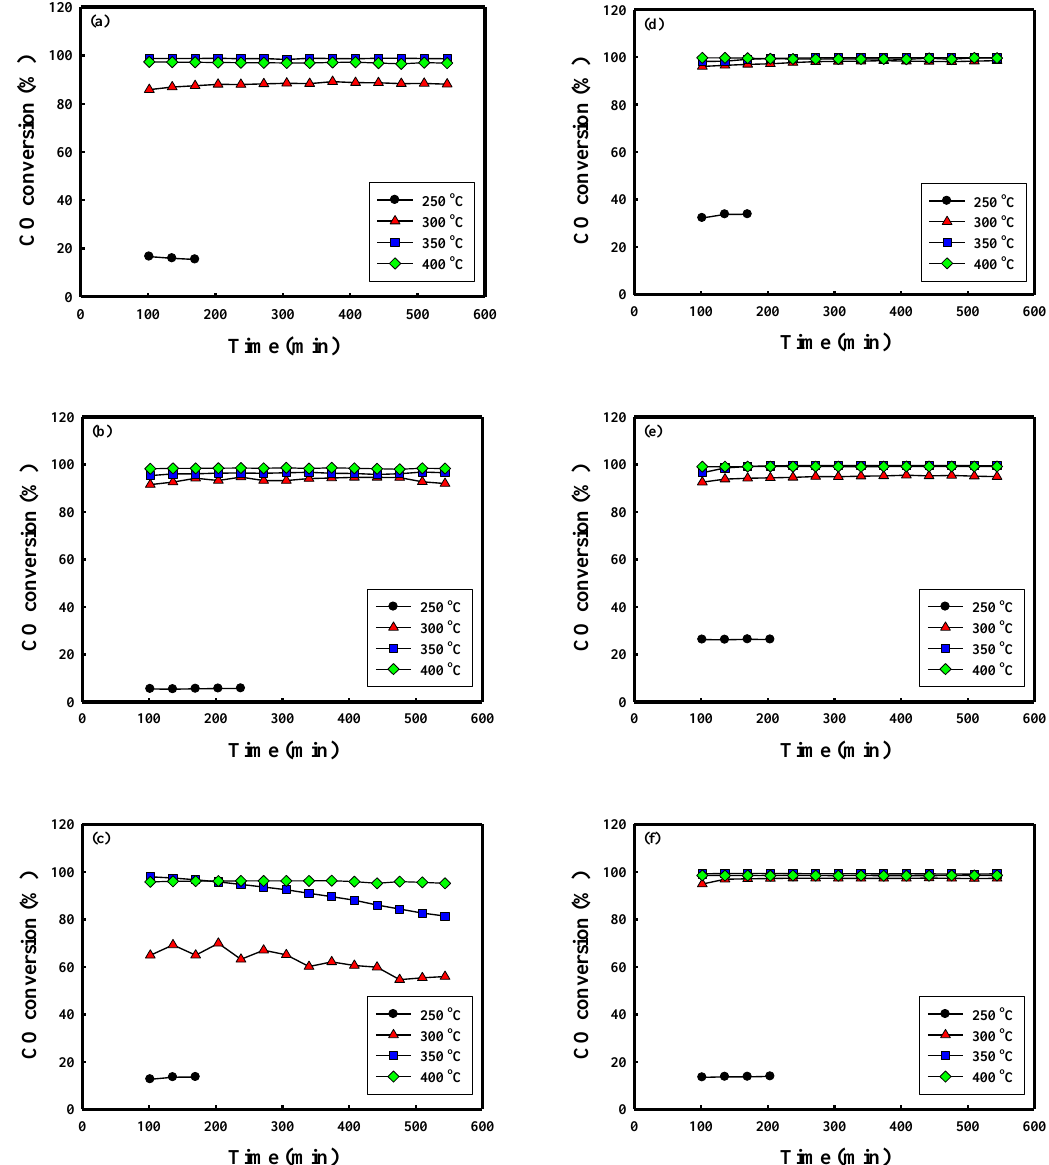
Figure 2. CO conversion of FT catalyst at different reaction temperature under 10 bar (left) and 20 bar (right) at space velocity of ( a , d ) 4000, ( b , e ) 6000, and ( c , f ) 8000 mL / g / h as a function of time on stream.